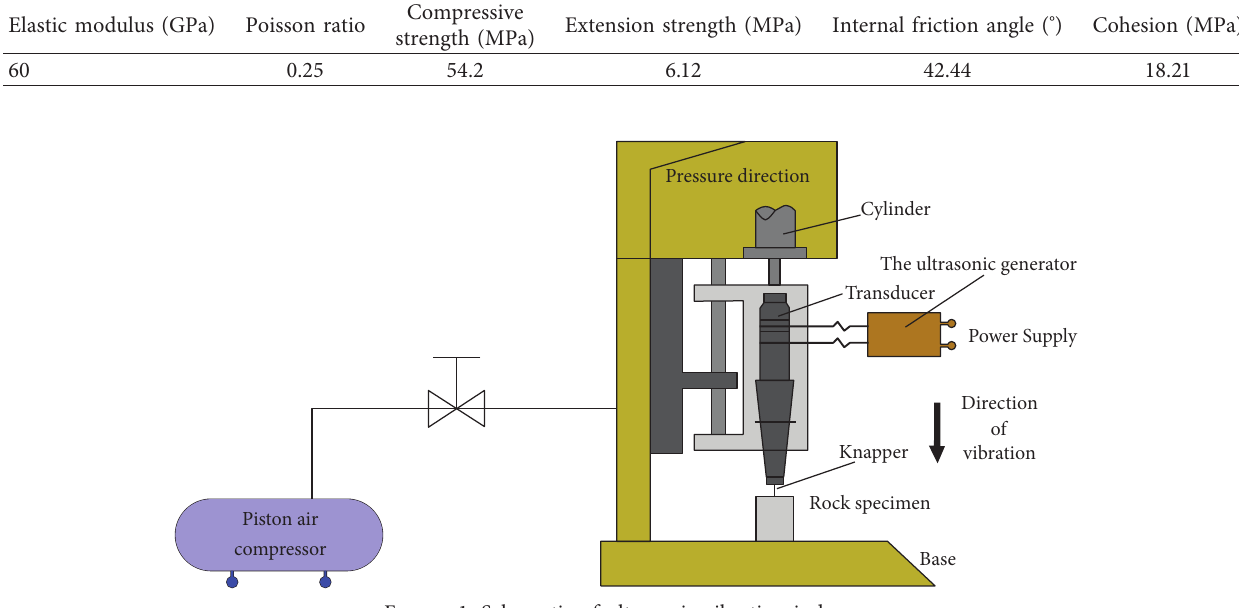
Table 1: Physical and mechanical parameters of red sandstone.